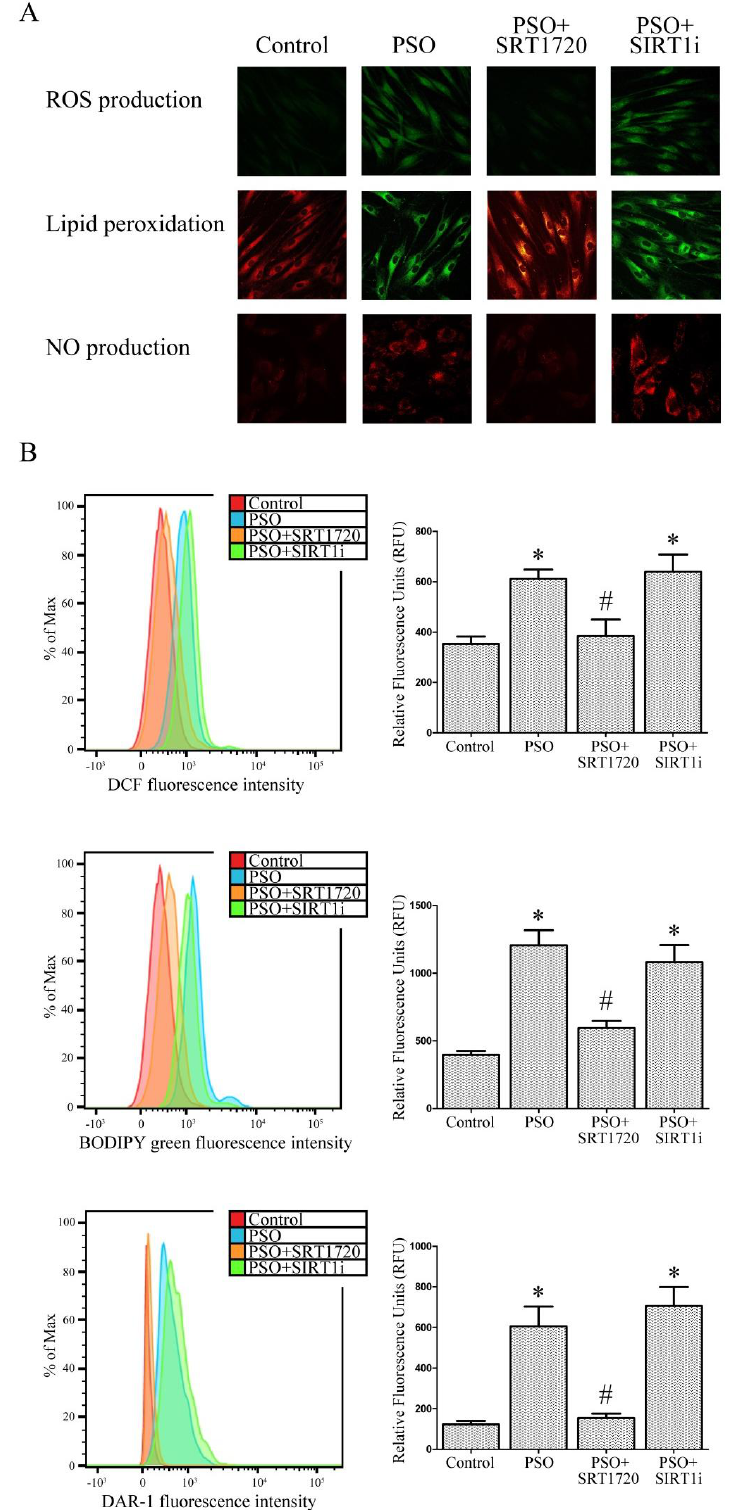
Figure 3. ( A ) Confocal microscope analysis (63× magnification) and ( B ) FACS analysis of ROS production, lipoperoxidation and NO production in fibroblasts from controls ( n = 4 biopsies) and psoriatic patients ( n = 4 biopsies) in the presence of SRT1720 or the SIRT1 inhibitor (SIRT1i). Each experiment was performed in triplicate. * Significant difference ( p ≤ 0.05) vs. fibroblasts from healthy patients. # Significant difference ( p ≤ 0.05) vs. fibroblasts from psoriatic patients.